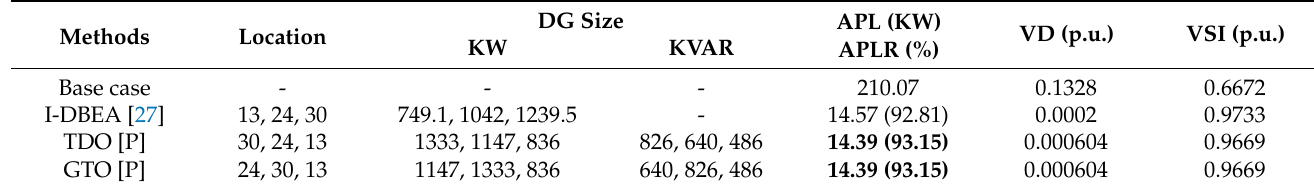
Table 5. Results comparison of OADG for a 33-bus RDN for the SOF (with APL minimization) at 0.85 pf (WT type) in the CP load